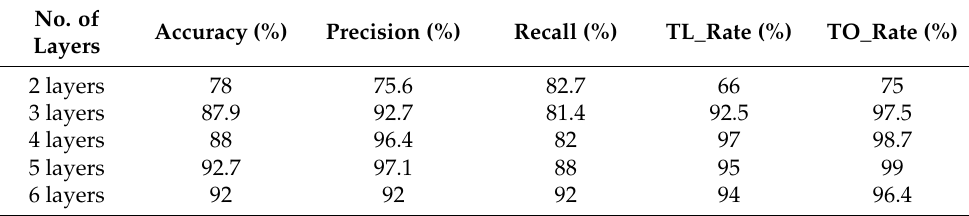
Table 4. Defect inspection results according to the number of layers. No.